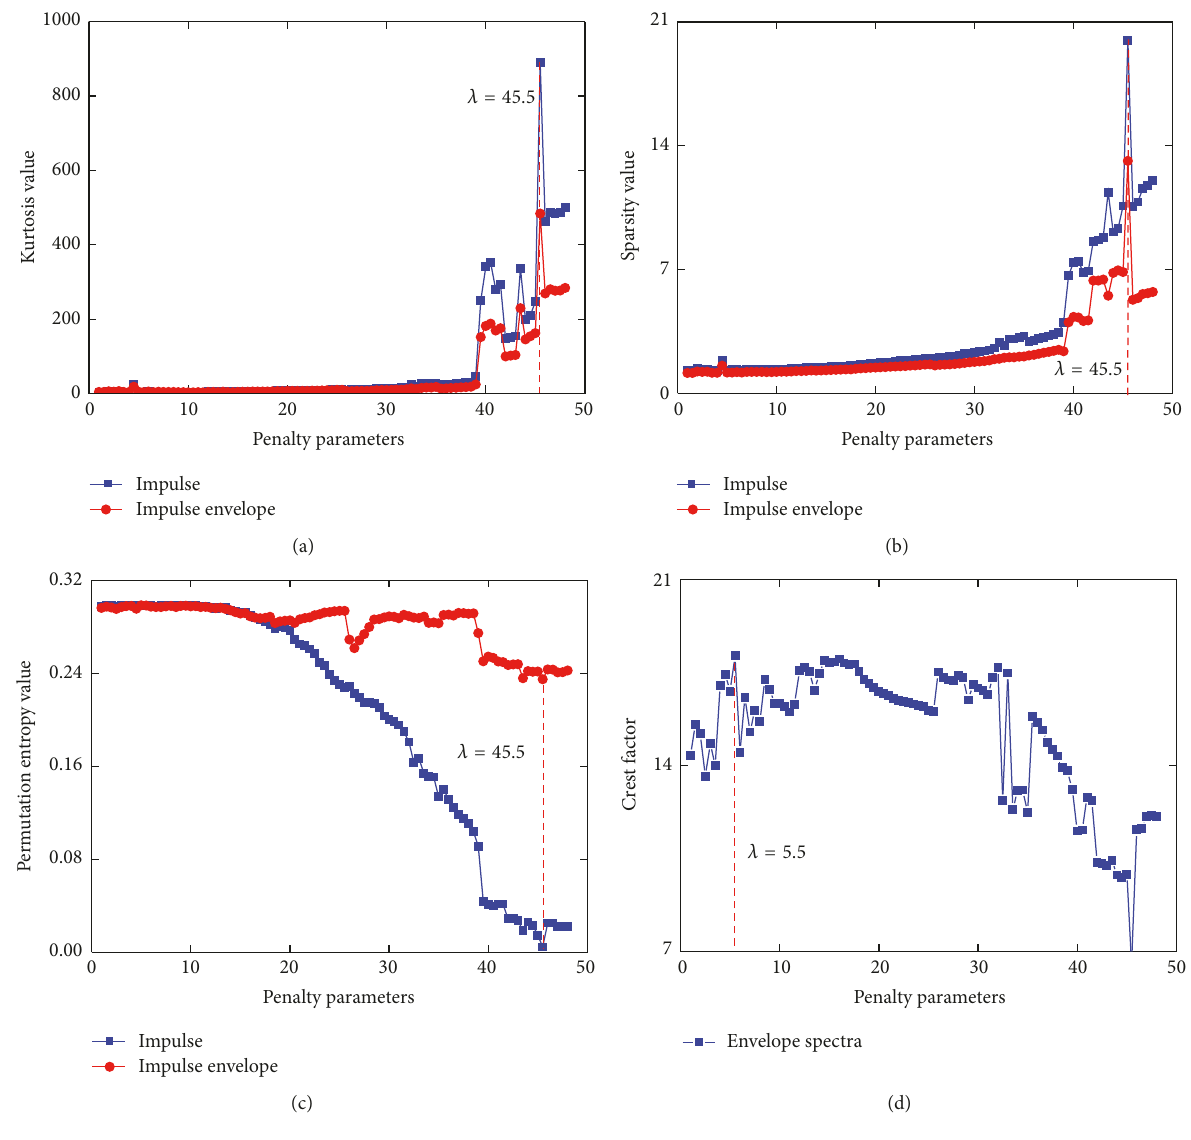
Figure 22: Four indicators for selecting